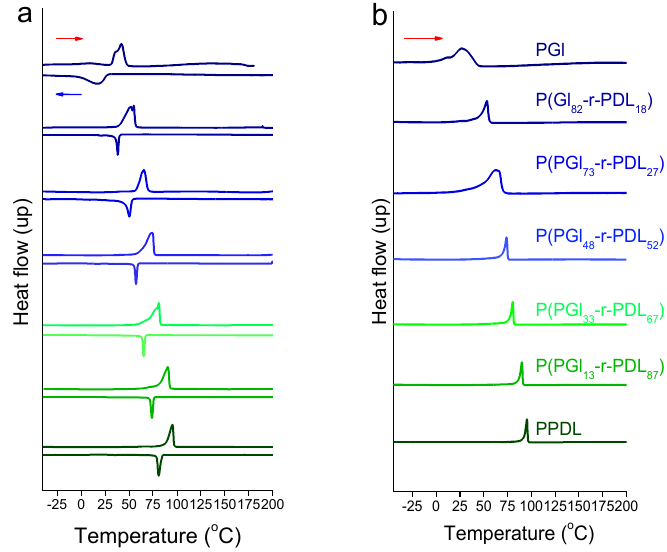
Figure 1. Differential scanning calorimetry (DSC) traces of P(Gl x - r -PDL y ) copolyesters recorded at the first heating and subsequent cooling ( a ) and the second heating ( b ) in the −30 to 200 °C range.